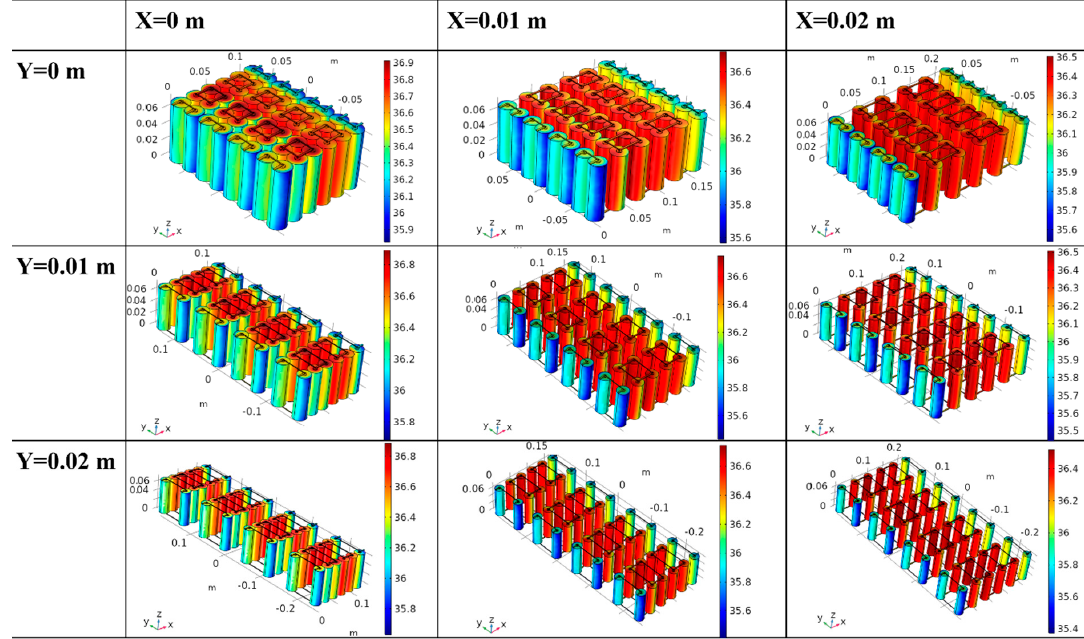
Figure 4. Temperature contours of different battery pack configurations.